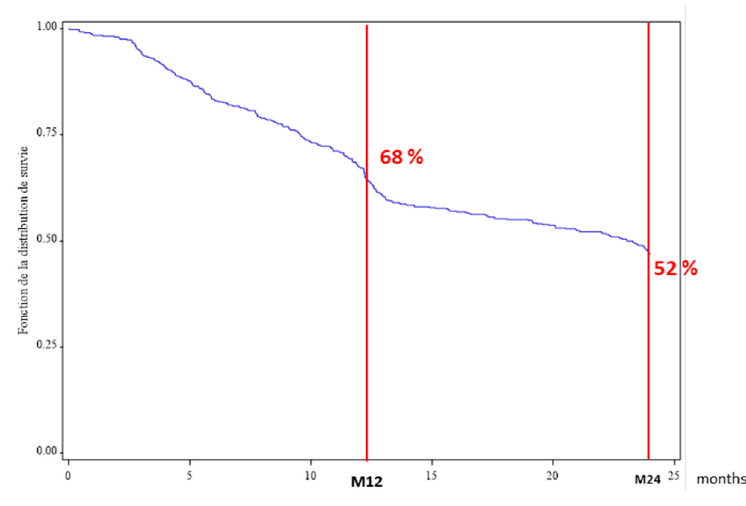
Figure 2. Abatacept persistence at 12 and 24 months.